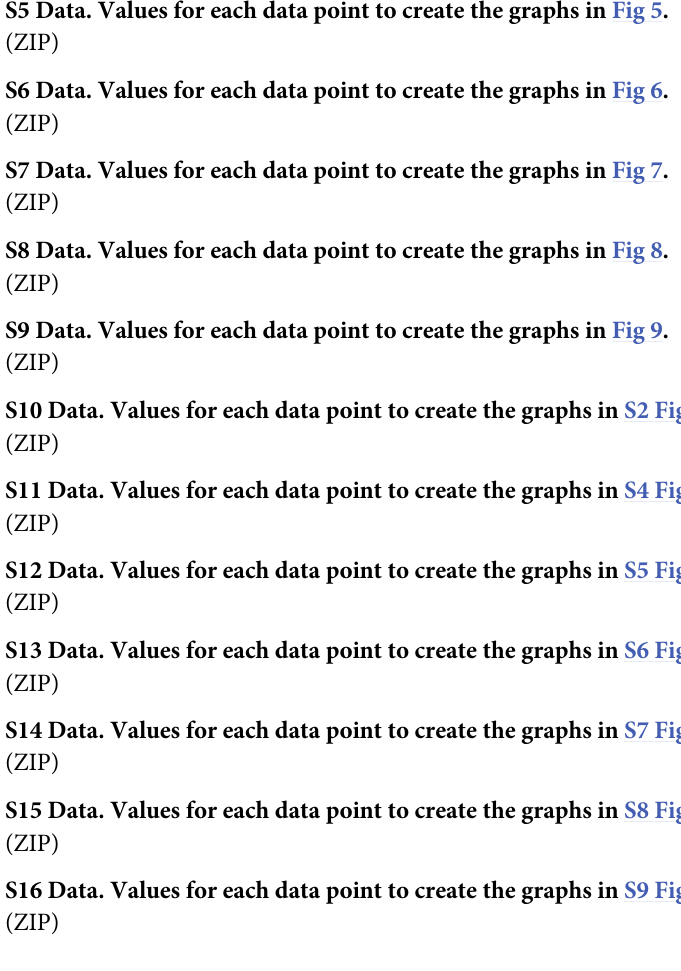
S1 Table. Genetic interaction of scd1 Δ , scd2 Δ , ras1 Δ , and gef1 Δ . Supporting information for Table 1, showing the genetic crosses performed and the number of spores of indicated geno- types analyzed by tetrad dissection. S2 Table. List of strains used in this study.